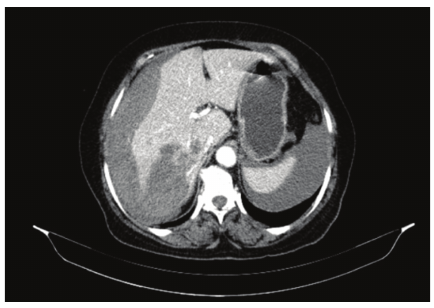
Figure 1: Preoperative abdominal computed tomography.